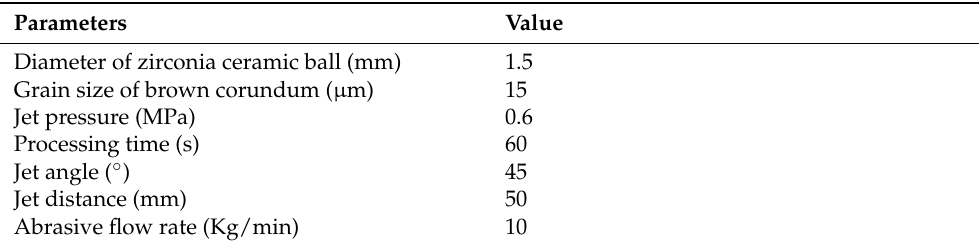
Figure 2. ( a ) Schematic of the strengthening processing equipment, ( b ) high-pressure jetting system, ( c ) processing procedure, ( d ) SP treatment, and ( e ) SGP processing. Table 3. The technological parameters for strengthening grinding